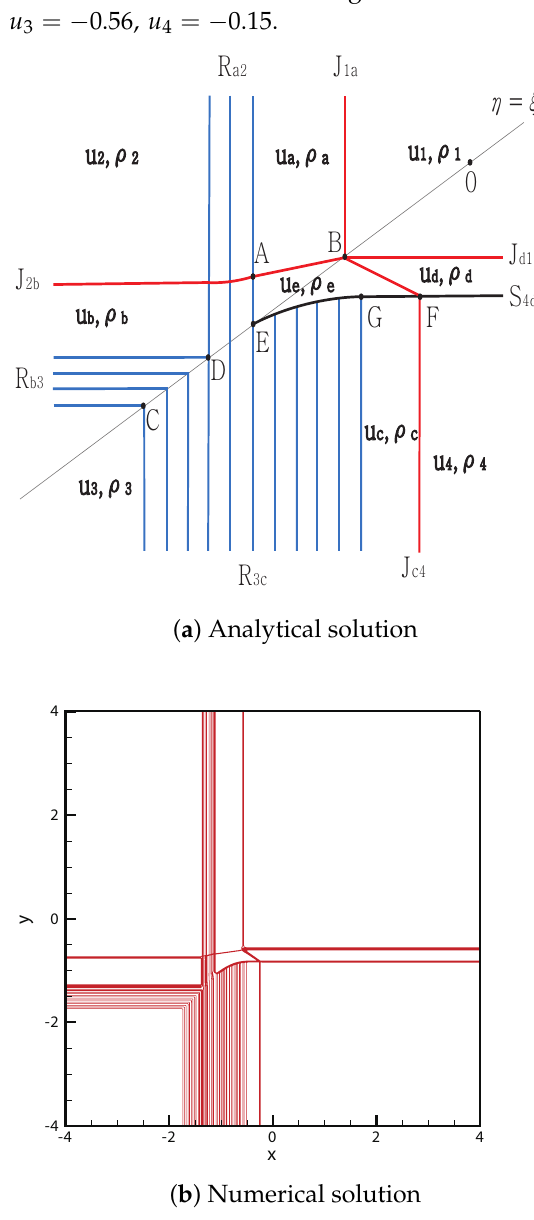
Figure 6. Case 4. JR + JR + RJ +